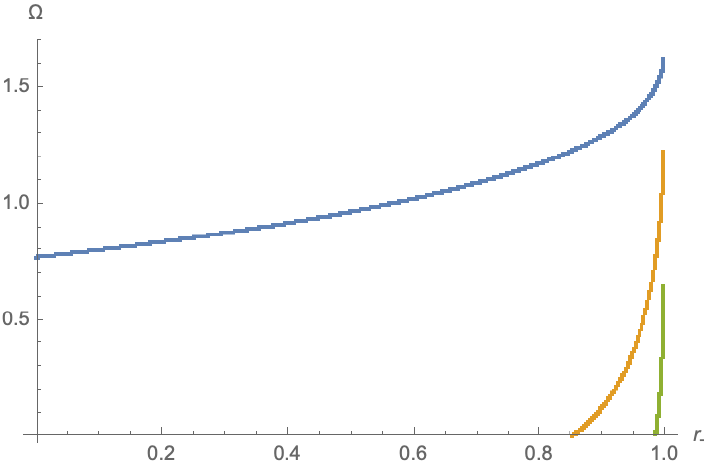
Figure 3 . Figure showing the eigenvalues, Ω , for the unstable modes for the flow of the electrically charged RN solution against r − for r − ≤ 0 . 999 (and for Einstein-Maxwell flow parameter τ = 1 ). The GPY negative mode at r − = 0 continues to an unstable mode of the electrically charged solutions. However additional negative modes appear as the charge is increased. For r − ≤ 0 . 999 up to three unstable modes may exist, but very near extremality, for 0 . 999 < r − < 1 (not shown in the plot) more unstable modes appear. It therefore appears that electrically charged RN is an unstable fixed point of the EM flow near extremality, unlike the magnetically charged RN solution which is